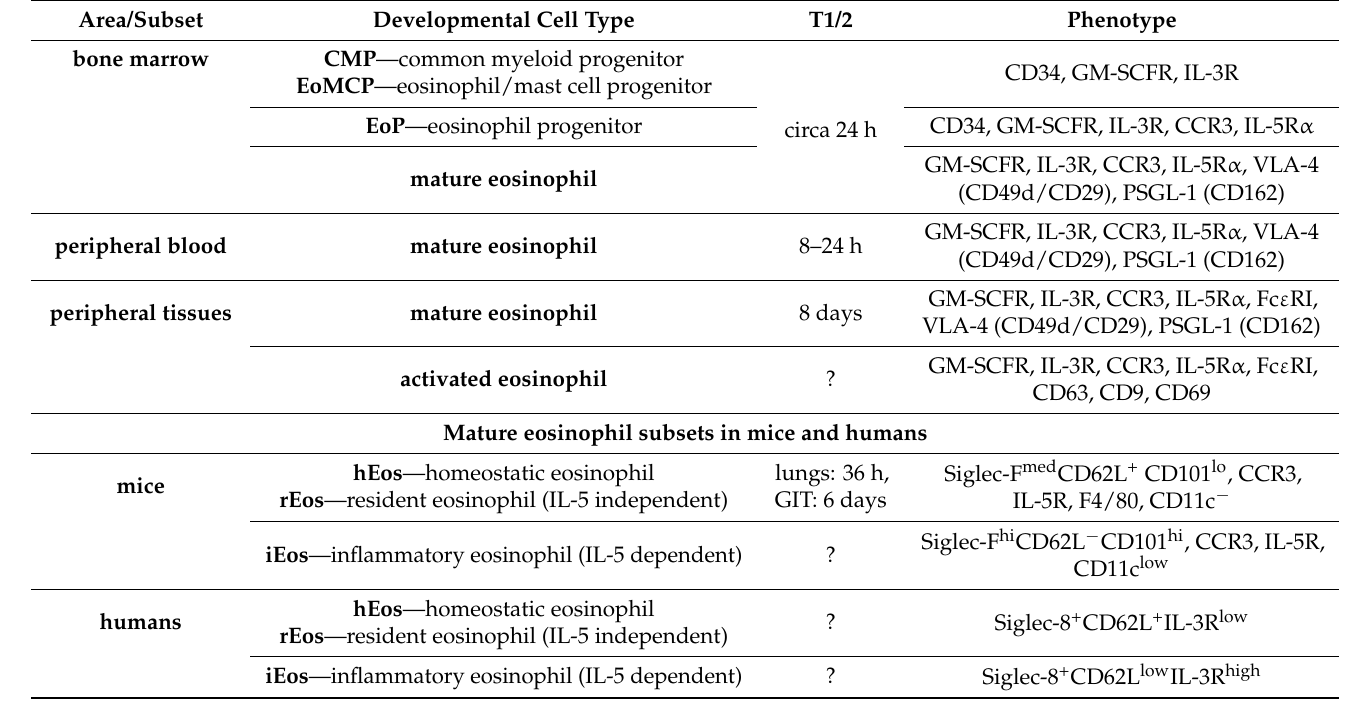
Table 1. Development of